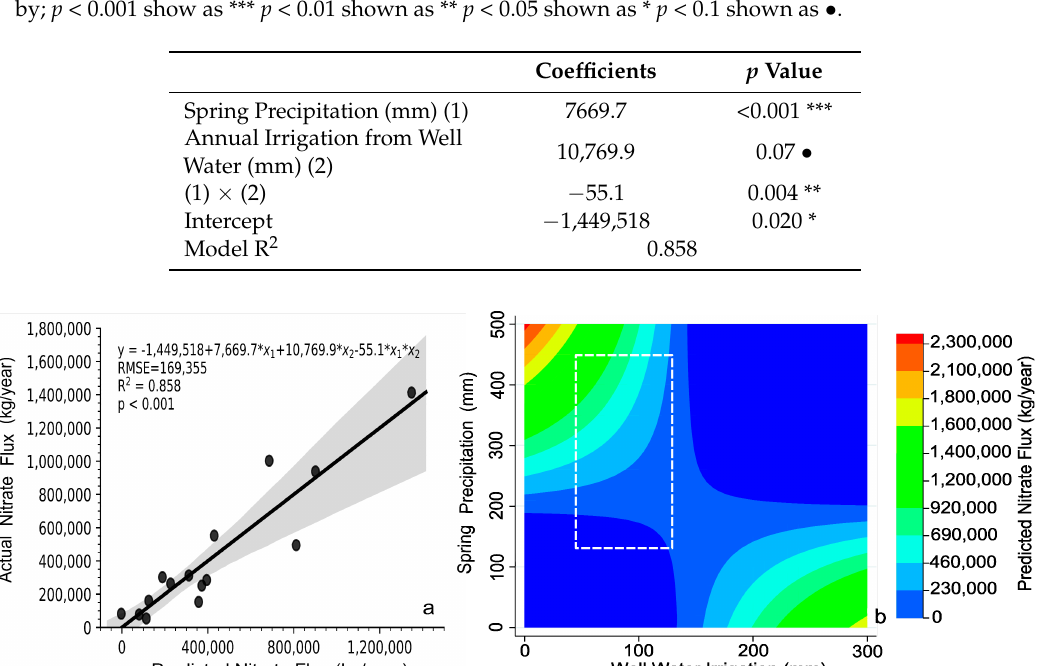
Table 2. The multiple linear regression analysis between the two significant variables of spring precipitation and annual well irrigation, and annual nitrate flux ( n = 15). Significance levels are denoted by; p < 0.001 show as *** p < 0.01 shown as ** p < 0.05 shown as * p < 0.1 shown as • .